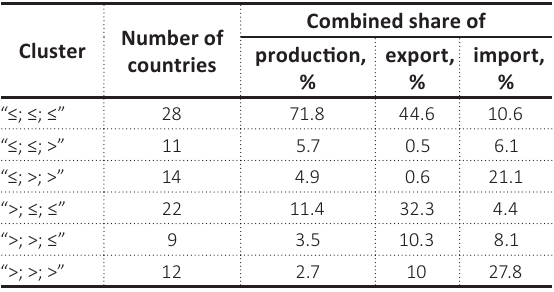
Table 1. Clusters characteristics in the world apple market